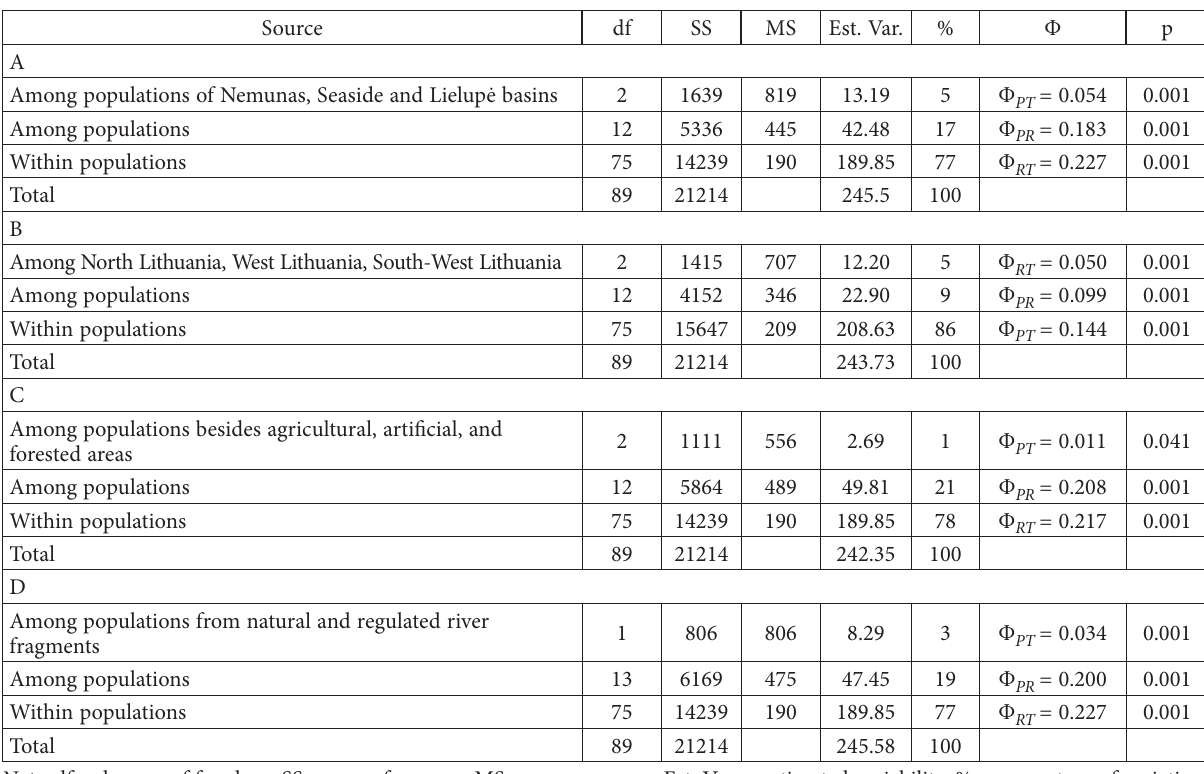
Table 5. AFLP loci based hierarchical analysis of molecular variance (AMOVA) among populations of Lythrum salicaria